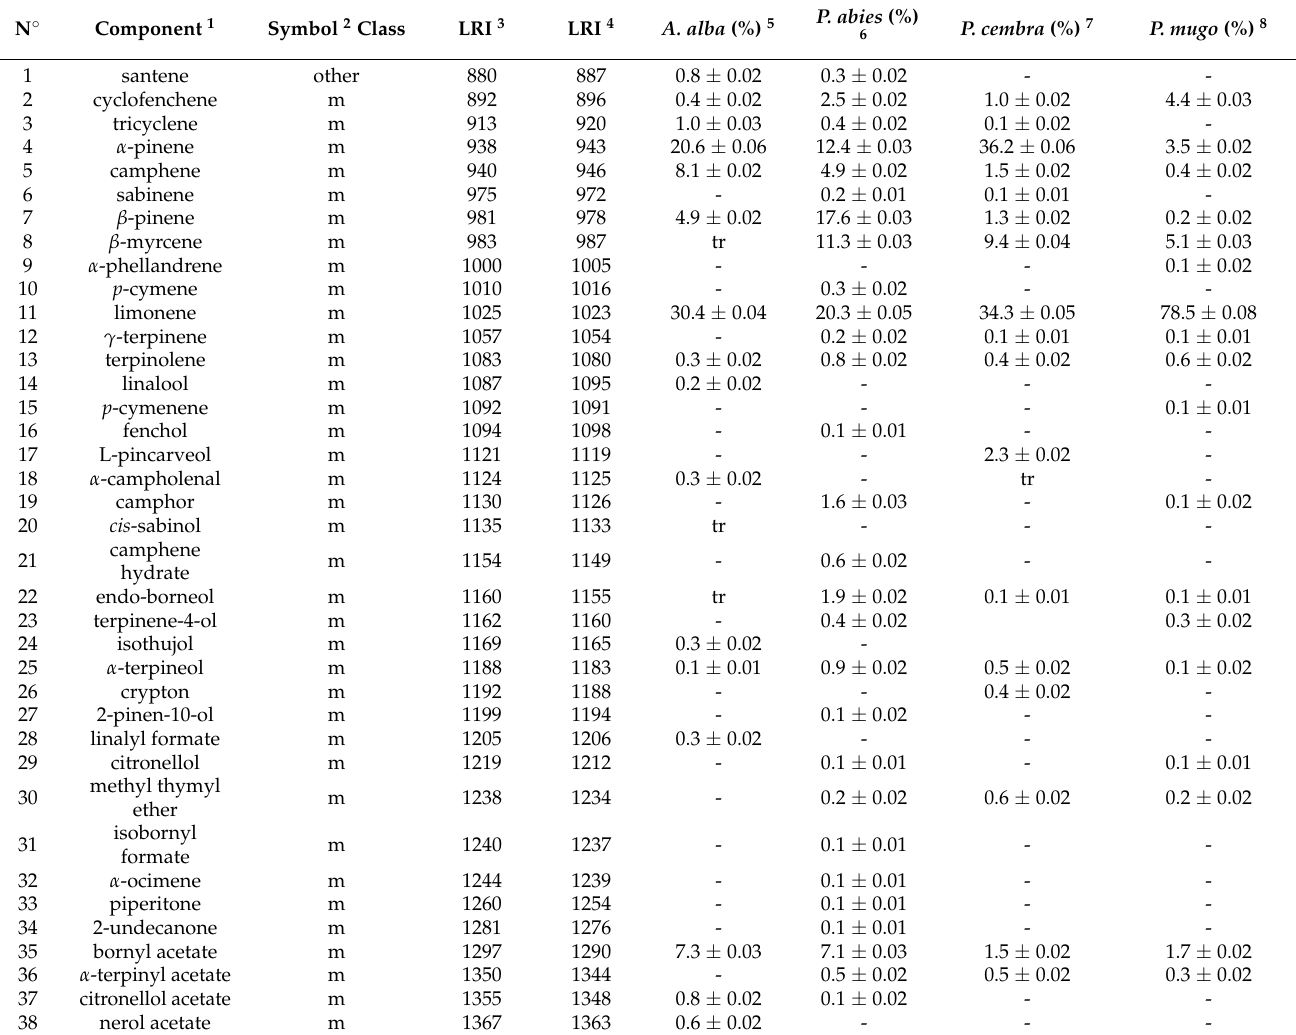
Table 2. Liquid phase chemical composition (%) of A. alba , P. abies , P. cembra and P. mugo EOs, as determined by